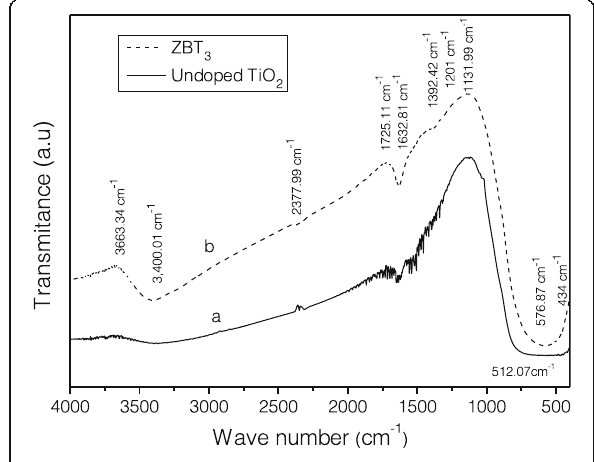
Fig. 3 FT-IR spectra of ( a ) undoped TiO 2 and ( b ) 0.5 wt% of Zn & 0.5 wt% of B co-doped TiO